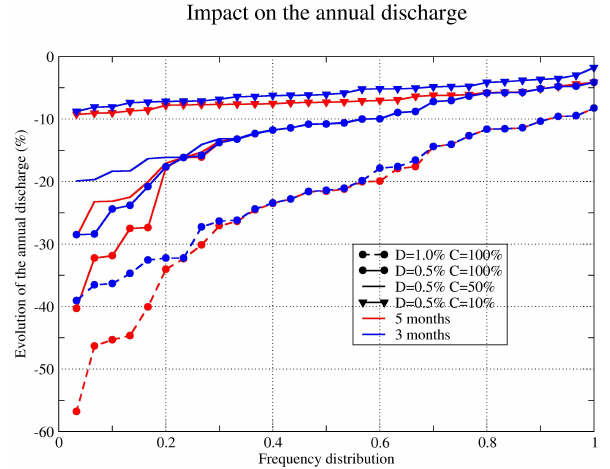
Figure 6. Frequency analysis of the impact of the small farm dams on the annual river flow according to their storage capacity and the impact of the size of the filling catchment.